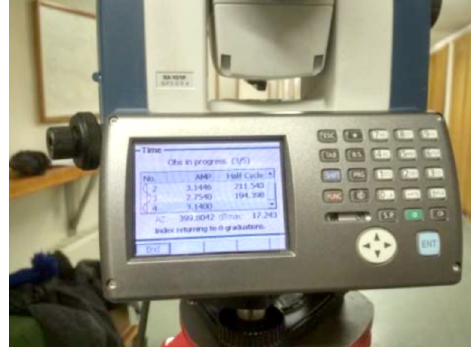
Figure 2. Example of the Follow